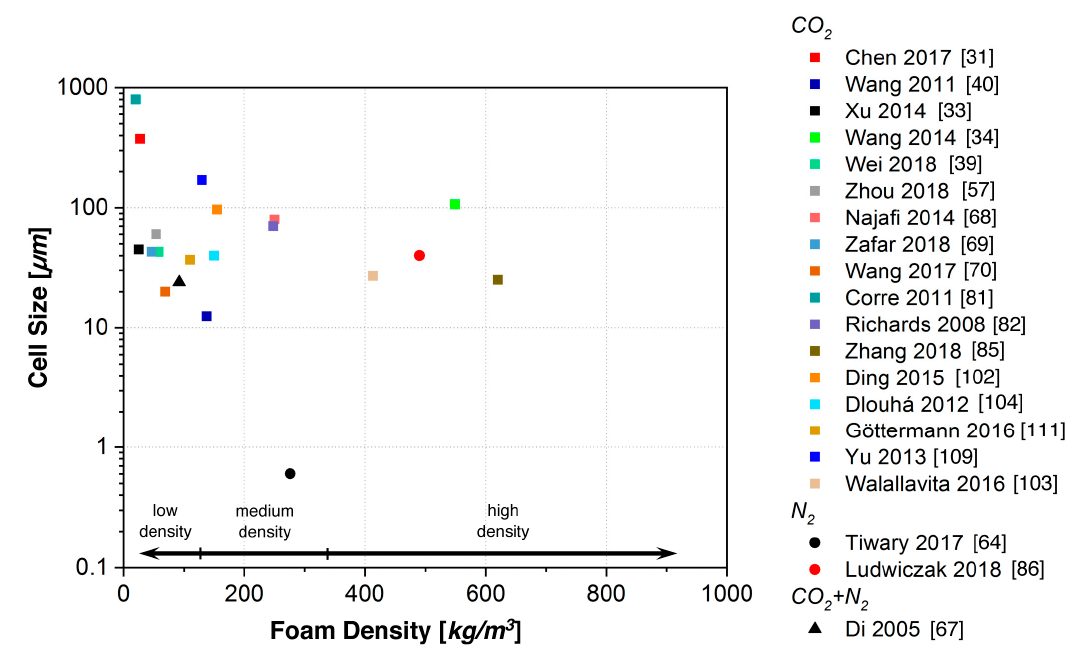
Figure 3. Overview of the literature on batch-foamed PLA (lowest density values with corresponding cell sizes within the given range were considered).